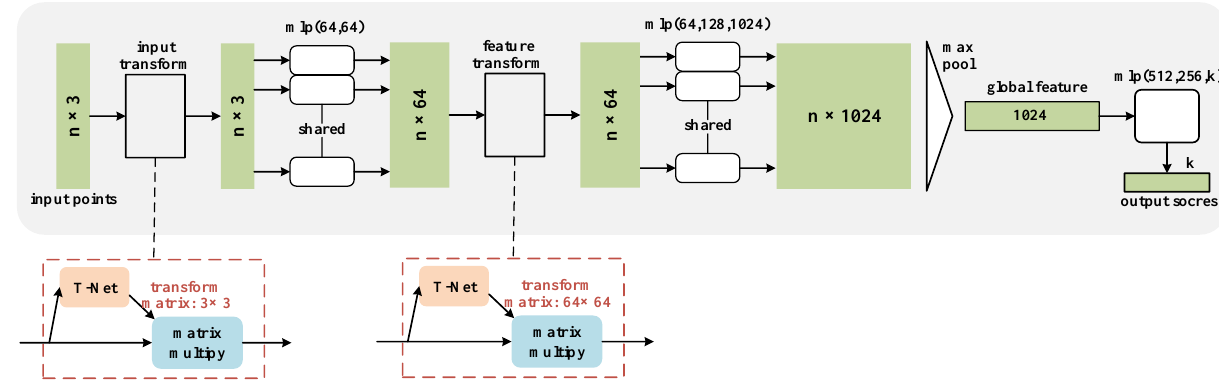
Figure 6. Overall structure of point cloud classification network. The dotted boxes are input point cloud T-Net network and feature transformation T-Net network respectively.